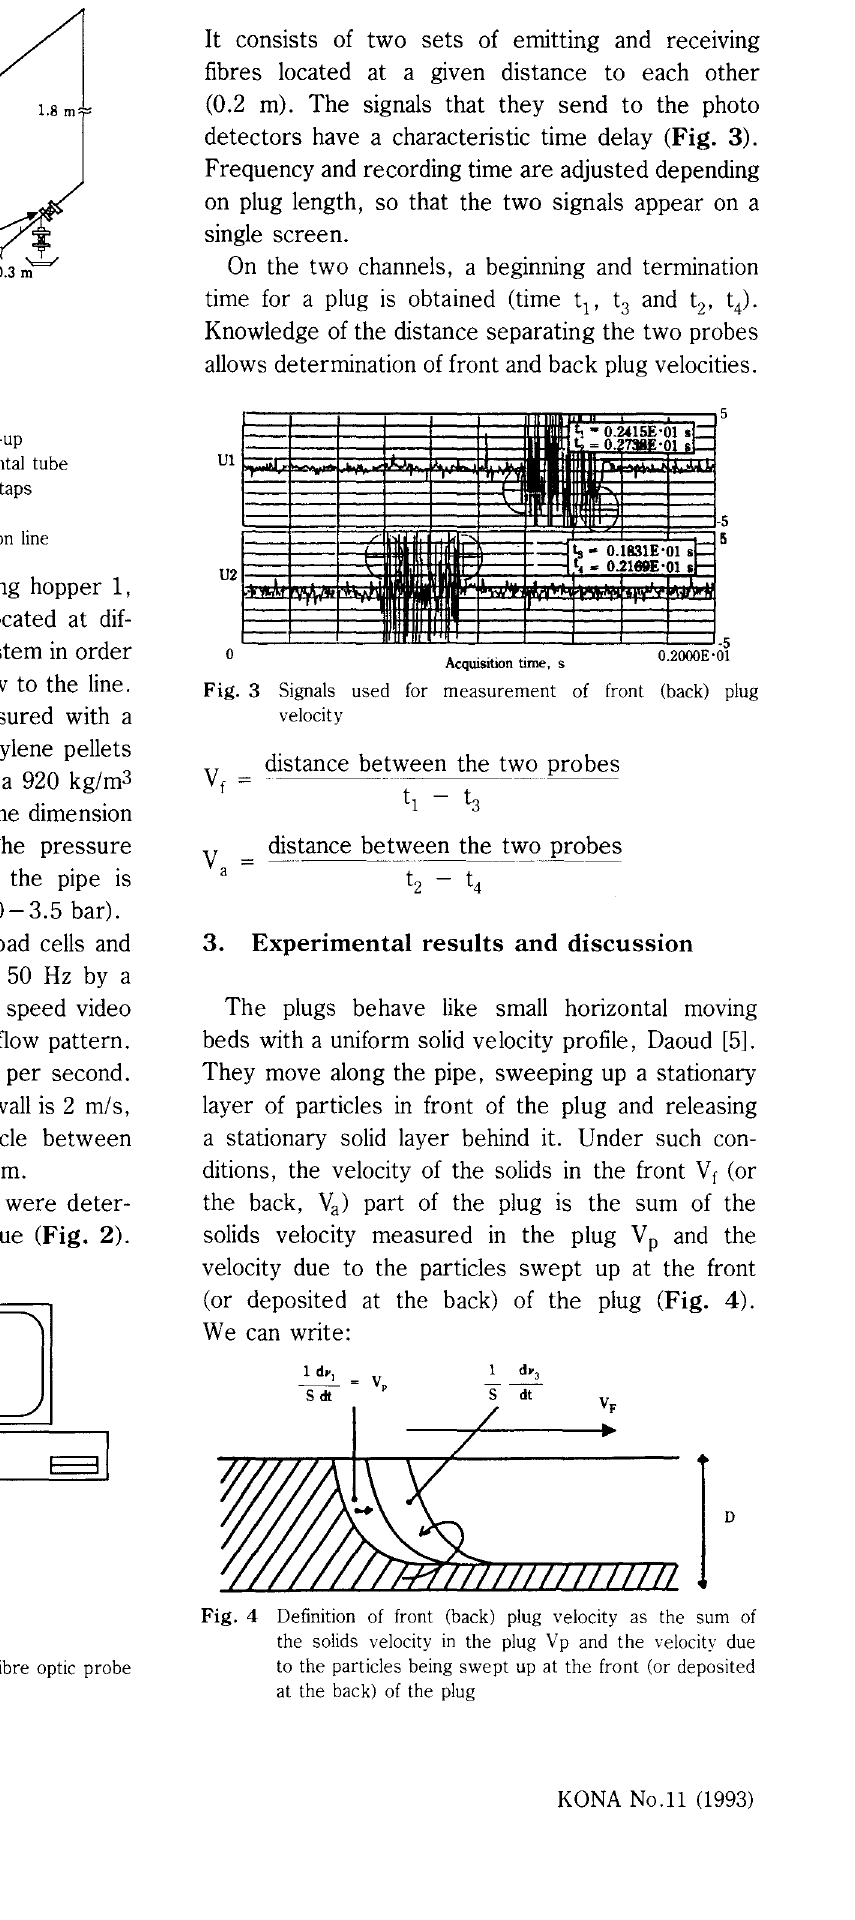
Fig. 2 Set-up for velocity measurements with fibre optic probe technique